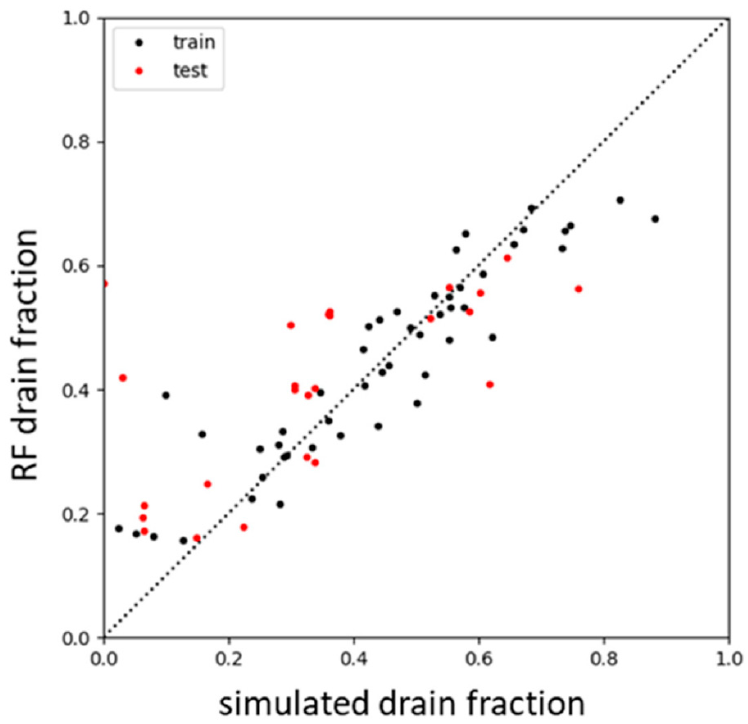
Figure 4. Results from using hydrograph signatures in RF regression for predicting drain fraction for individual ID15 sub-catchments as simulated by the Storå and Odense models.